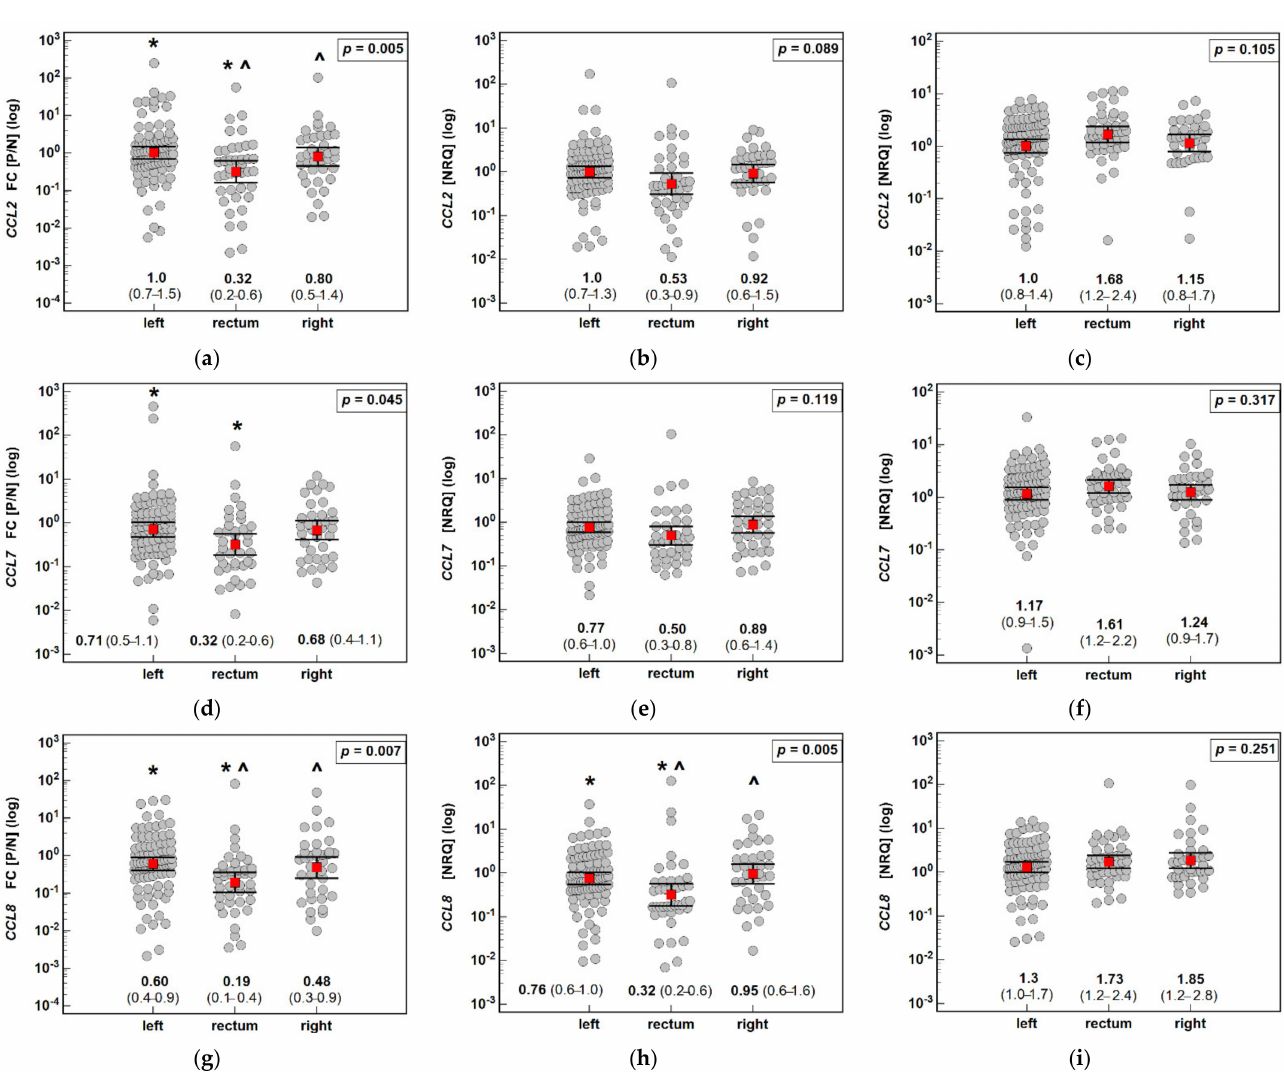
Figure 8. Effect of the anatomical subsite on the expression (mRNA) of MCP chemokines in patients with colorectal polyps: ( a ) fold change (FC) in CCL2 expression between the polyp and normal mucosa (P/N); ( b ) CCL2 expression in a polyp; ( c ) CCL2 expression in normal tissue; ( d ) fold change (FC) in CCL7 expression between the polyp and normal mucosa (P/N); ( e ) CCL7 expression in a polyp; ( f ) CCL7 expression in normal tissue; ( g ) fold change (FC) in CCL8 expression between the polyp and normal mucosa (P/N); ( h ) CCL8 expression in a polyp; ( i ) CCL8 expression in normal tissue. Data analyzed as logarithms using one-way ANOVA with a Student–Newman–Keuls post hoc test and presented as means with 95% confidence intervals (red squares with whiskers and numbers below dot plots). Significant ( p < 0.05) differences between groups (identified in post hoc analysis) are indicated by the same symbol type (*, ˆ). NRQ: normalized relative